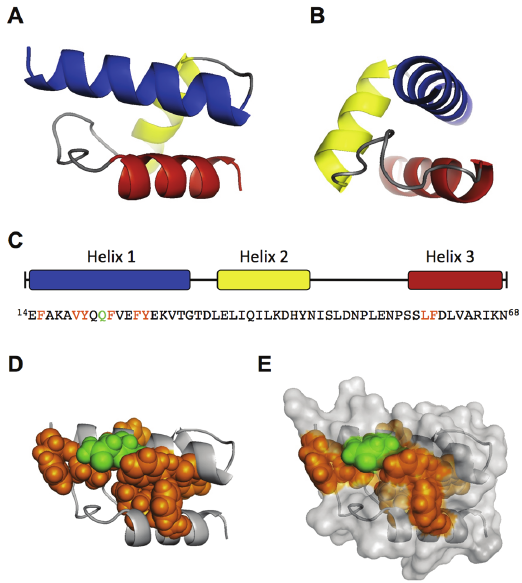
Figure 3. Ab initio modeling of the RBD. The central part of the RBD region (AA 14–68) was modeled by QUARK. ( A ) Front view of model 1 with the N-terminus left and C-terminus right. Helix 1 = blue (AA 14–31), helix 2 = yellow (35–45), helix 3 = red (57–68). Helix 1 shows a similar orientation as the schematic depiction in Figure 2E; ( B ) side view of (A), showing helix 1 similar to the helical wheel in Figure 2B; ( C ) Helix distribution and sequence of the modeled AA 14–68. The important amino acids for VP1u internalization are colored in orange (hydrophobic) and green (polar). The spatial cluster of the important amino acids is depicted as spheres in the helical structure ( D ) and in the surface model ( E ) of the RBD. Estimated TM-score of the shown Model 1: 0.5200 ± 0.0833. The structure was visualized with PyMOL.